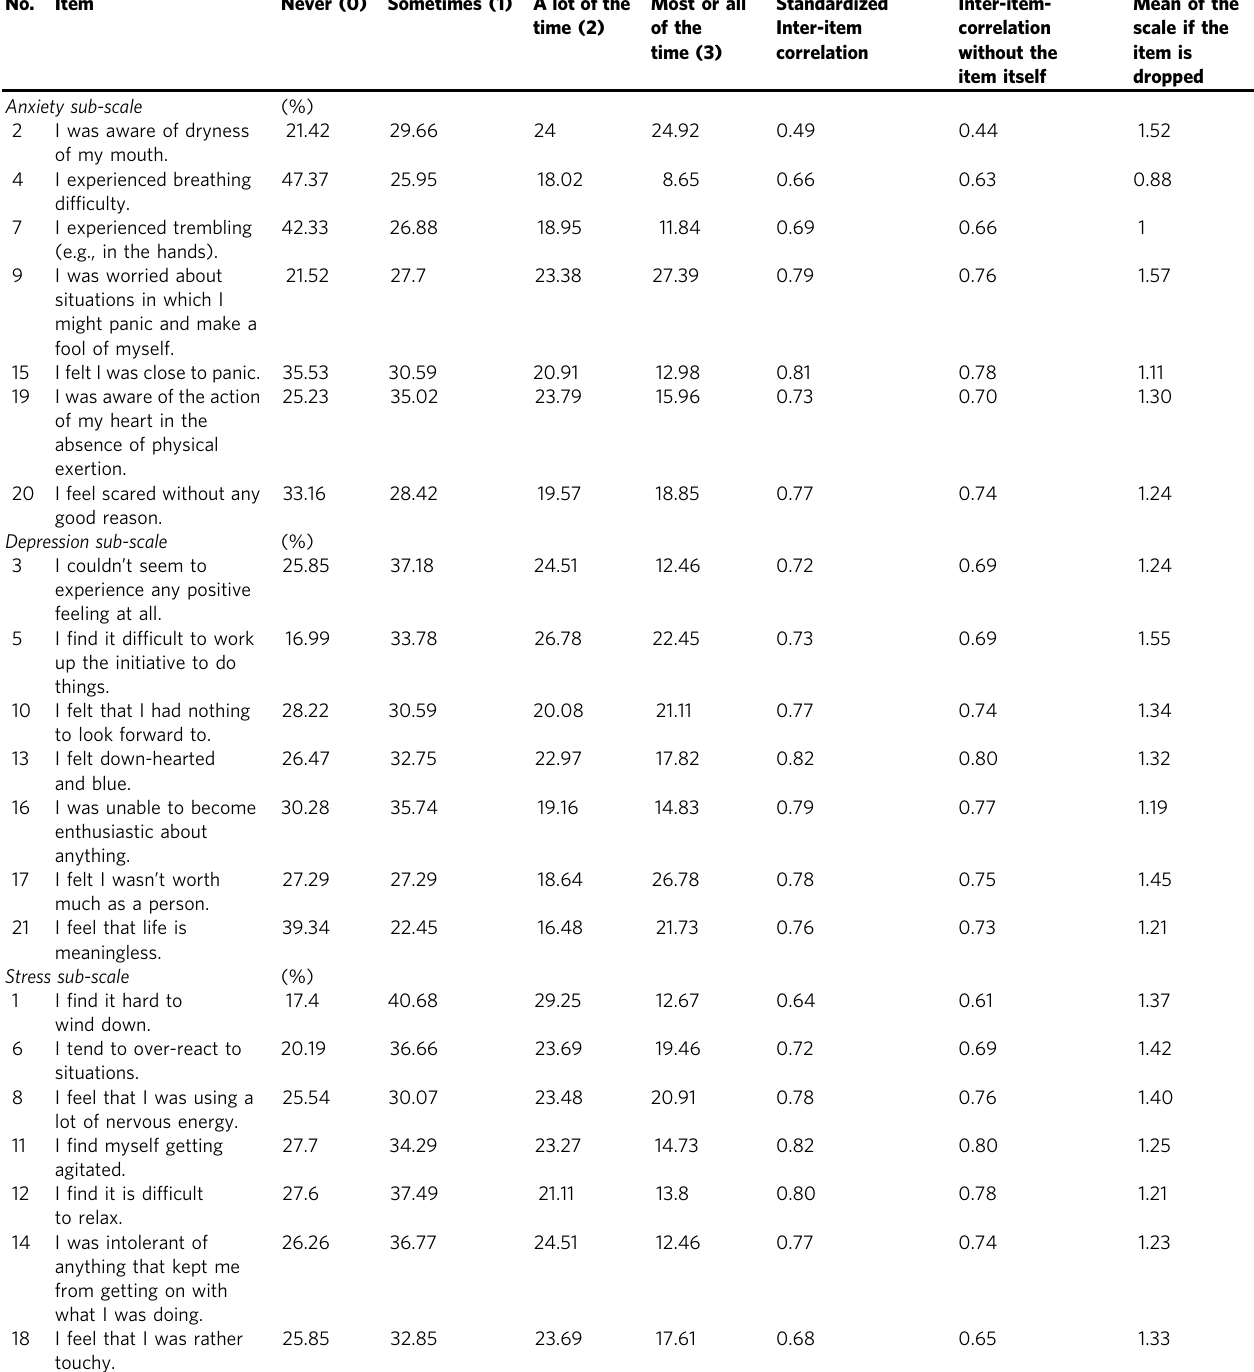
Table 2 Abbreviated item content, response category percentages, and classical test theory statistics of DASS-21 scale items. No. Item